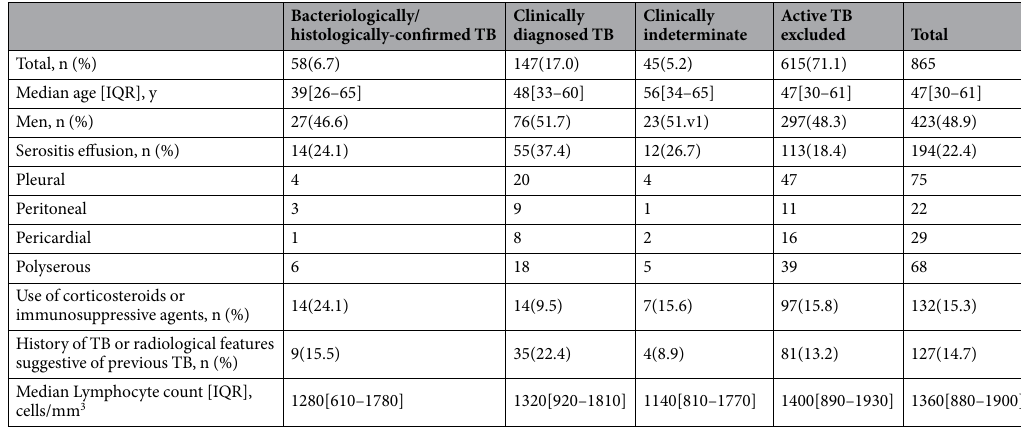
Table 2. Demographic, clinicalcharacteristics, and laboratory examinations of patients included.